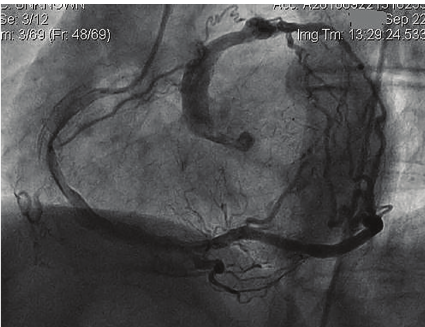
Figure1:Coronarycineangiogram.Leftanteriorobliqueprojection shows a single large right coronary artery originated from the right aortic sinus and extended to the left and terminating with a tortuous fistulisation into a cardiac chamber.